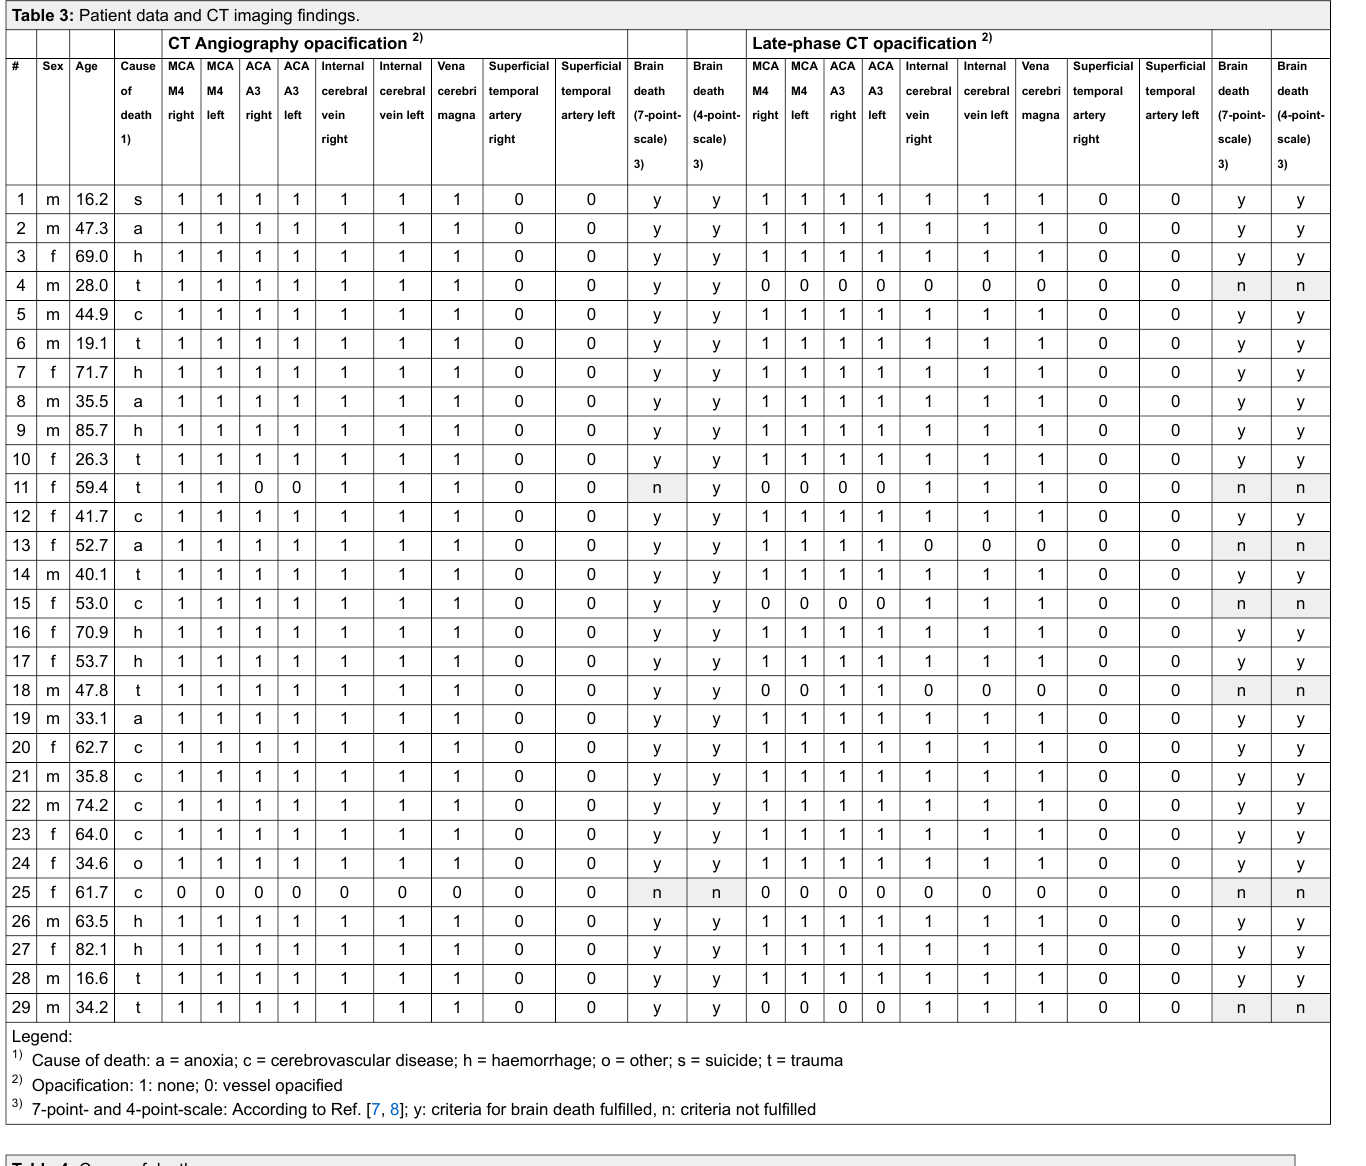
Table 4: Cause of